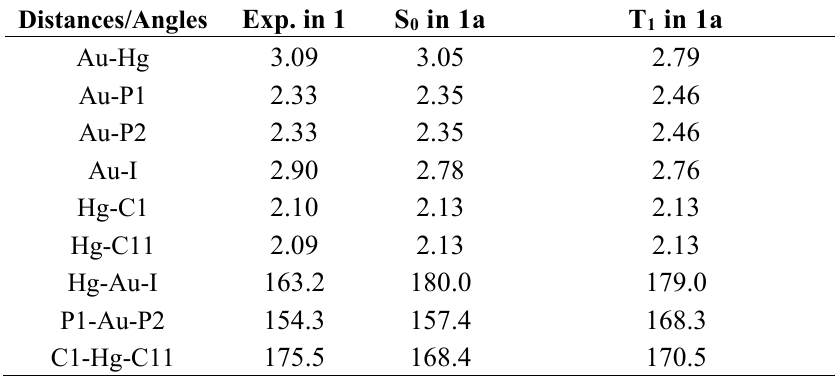
Figure 3. Fully optimized model system [AuHg( o -C 6 H 4 PH 2 ) 2 I] ( 1a ) in the ground (S 0 ) ( left ) and the lowest triplet excited state (T 1 ) ( right ). Table 3. Selected experimental and theoretical distances (Å) and angles (°) for complex excited (T 1 )